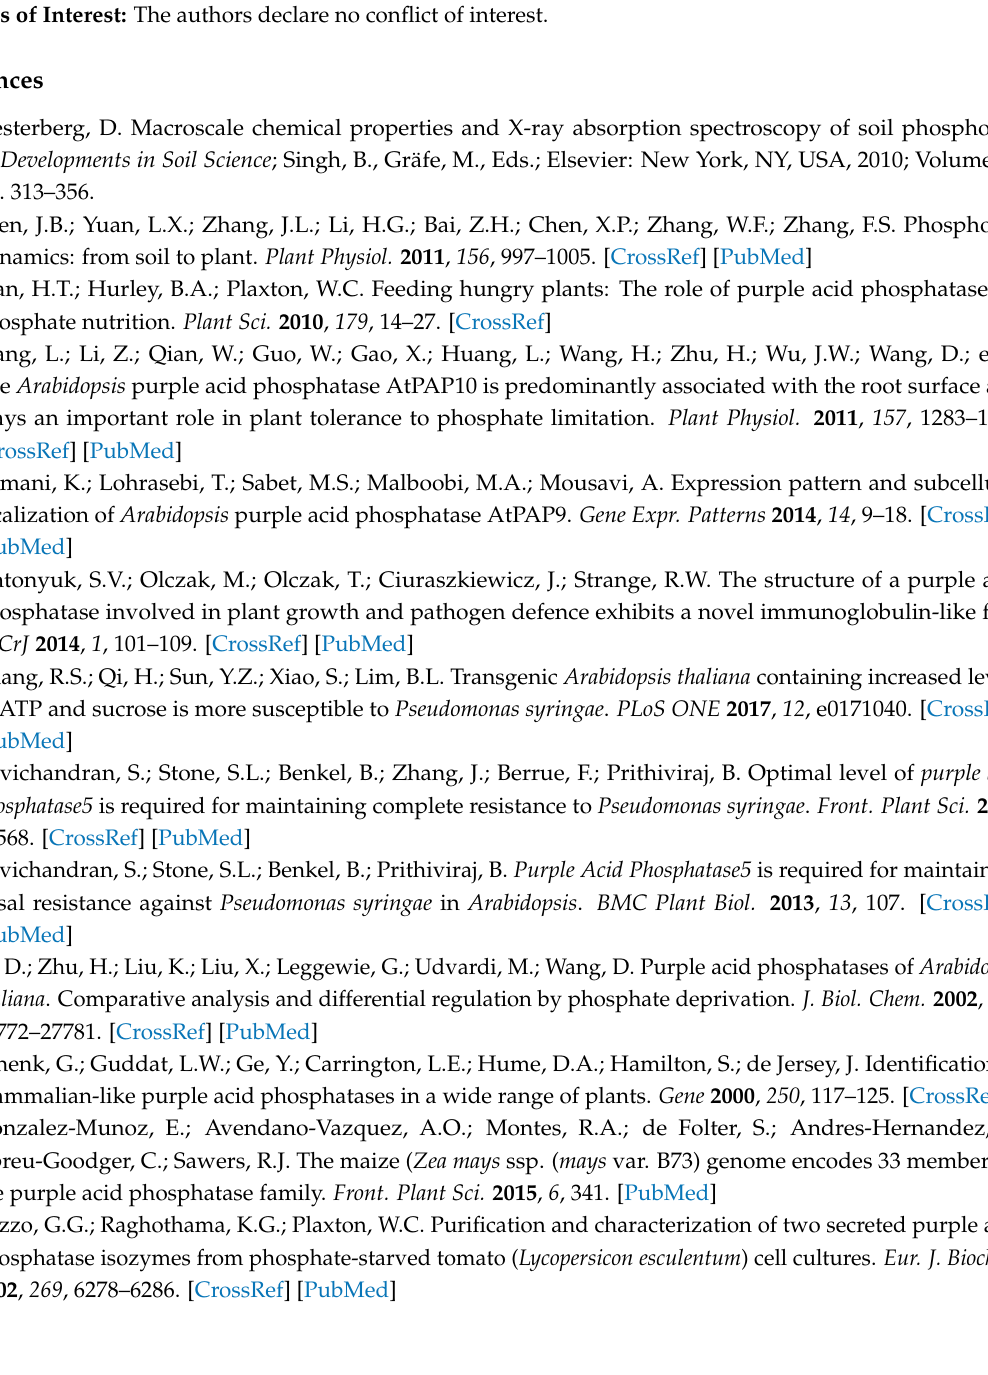
Table S1: Primers used in this study; Table S2: AtPAP2 homologs in various species included in the phylogenetic analysis and the BLAST